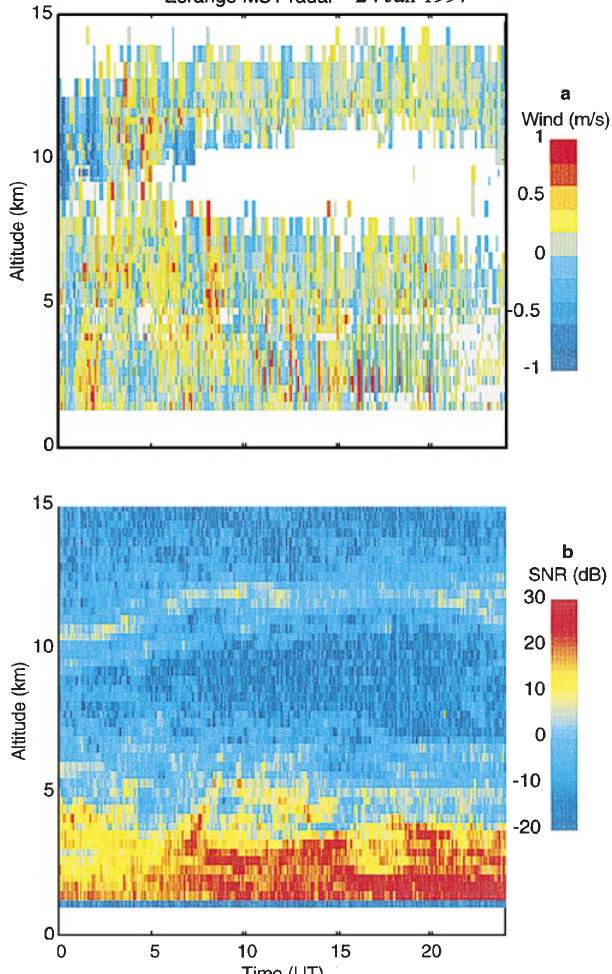
Fig. 3. ESRAD observations of vertical wind speed ( a ) and radar echo strength ( b ) for 24